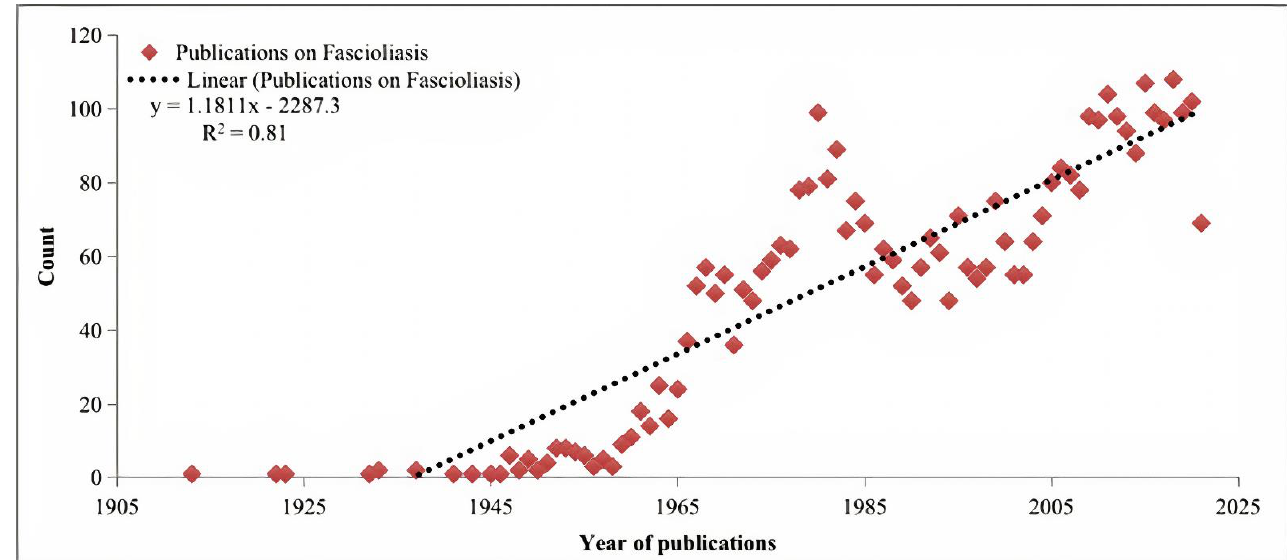
Figure 1. Time trend of publications on fascioliasis from 1903 to 2021.